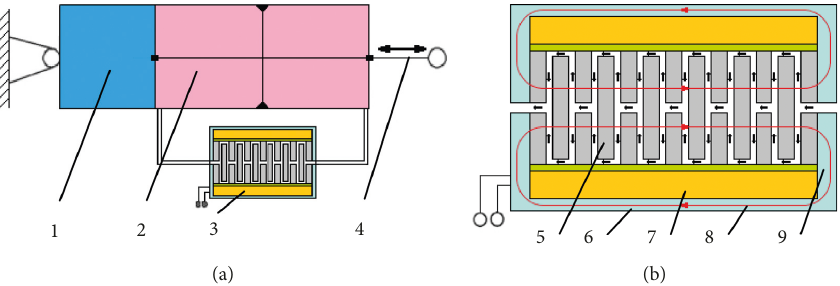
Figure 35: (a) Schematic view of bypass-type MR damper based on multistage radial flow mode. (b) Schematic view of MR valve. 1, hydraulic cylinder; 2, MRF; 3, MR valve; 4, piston rod; 5, core; 6, steel cylinder; 7, coil; 8, magnetic flux line; 9, end cap [77].